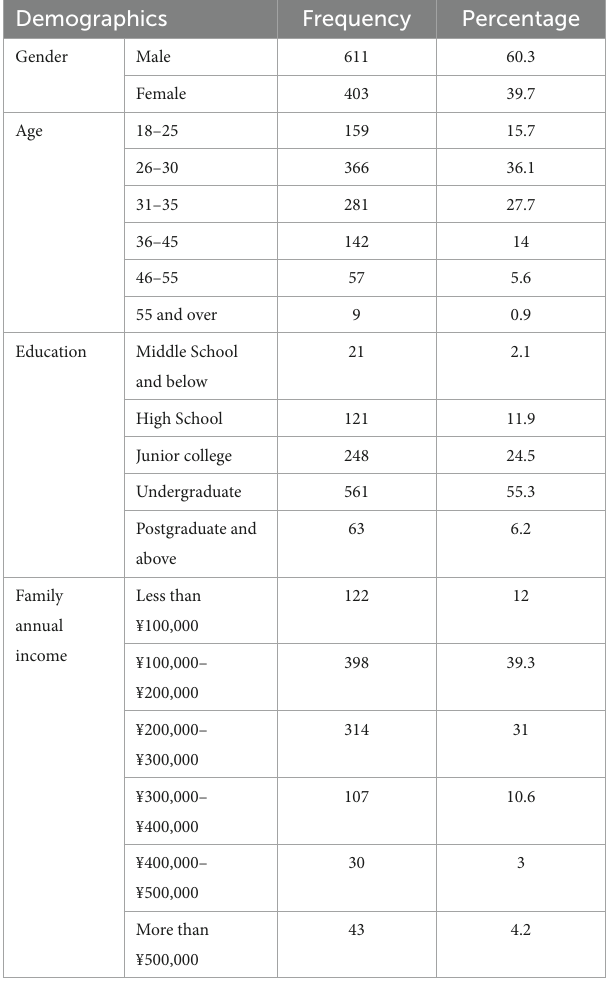
TABLE 1 Sample information ( N =